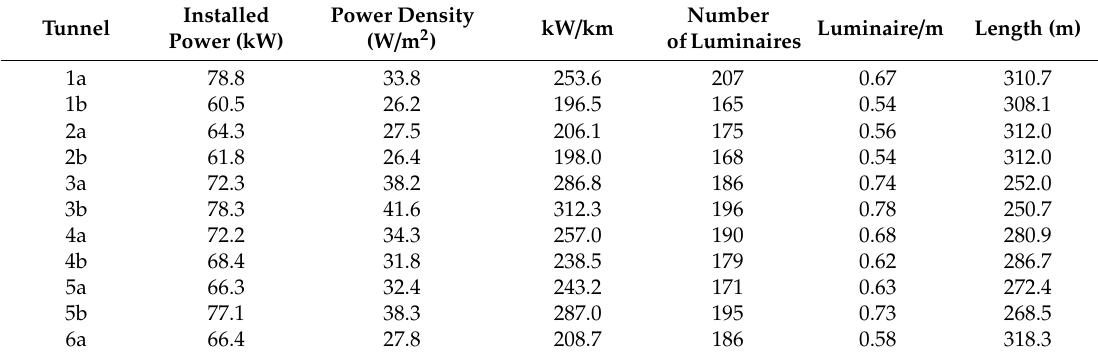
Table 9. Number of LED luminaires needed and the corresponding installed power and the energy indicators for the entrance zone of the examined tunnels for existing Lth luminance requirement.